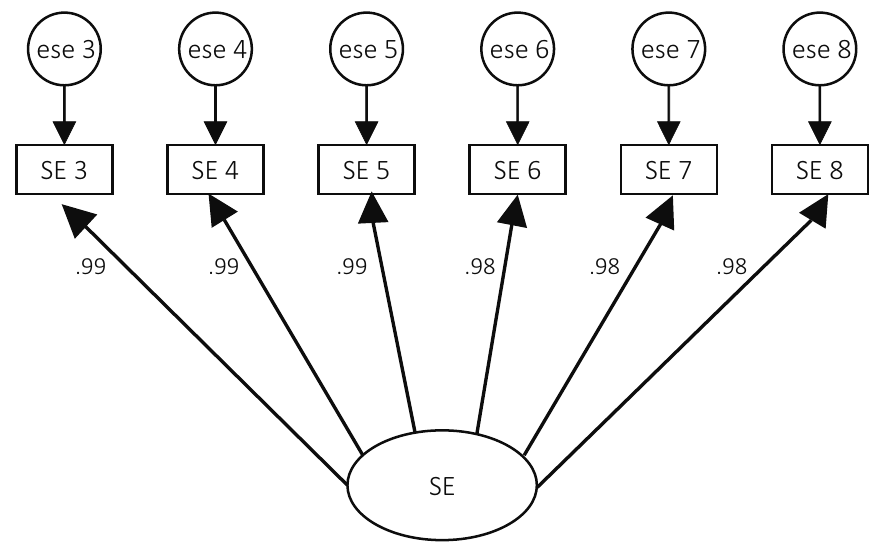
Figure 2. Path diagram of social entrepreneurship